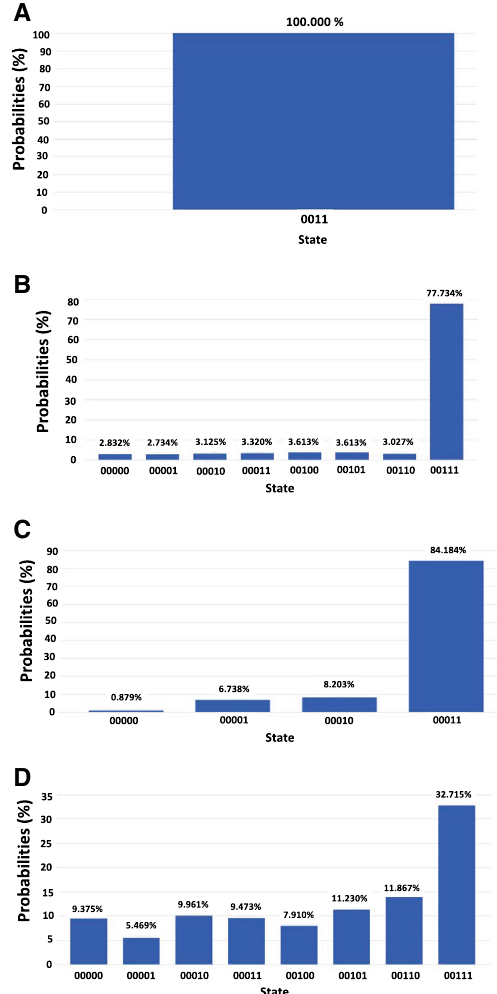
Figure 3. Grover’s algorithm applied to two- and three-qubit systems in Qiskit. The probability of each two- qubit ( A, C ) and three-qubit ( B, D ) state is presented upon measurement after one iteration of GA on the Qiskit simulator ( A, B ) and on real IBM QCs (C, D). The K–L divergence of real QC results from simulated results is 0.248 for two qubits and 0.603 for three